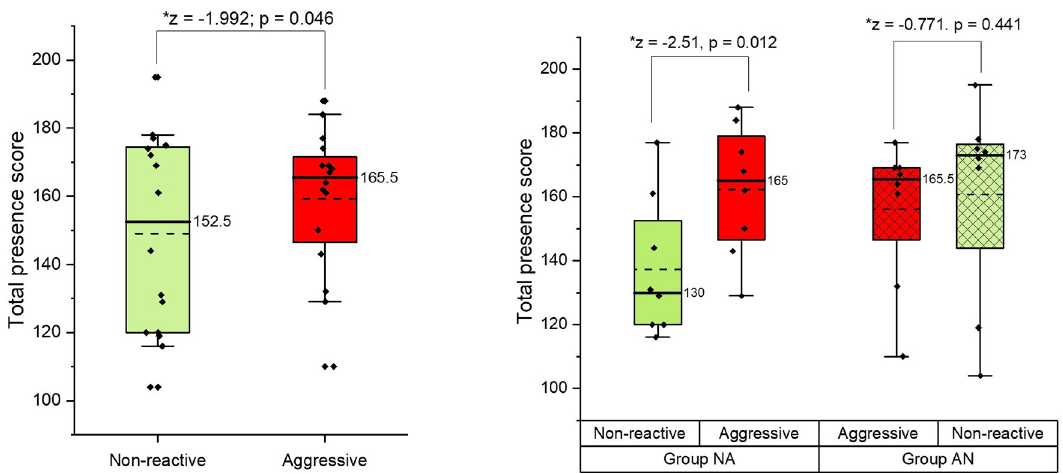
Fig 8. Boxplots for total presence scores and a) combined groups (NA and AN) by scenario (left) and b) comparisons between group NA and AN by scenario (right).